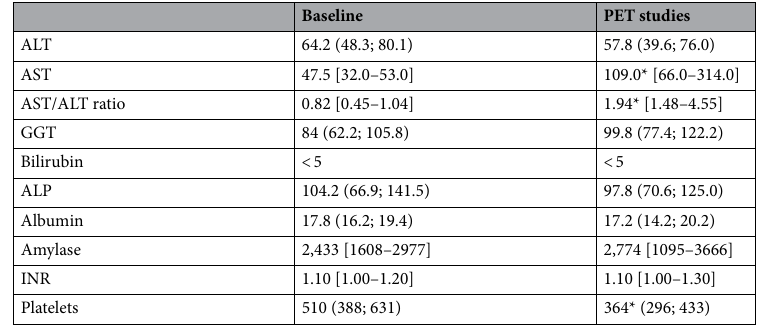
Table 1. Biochemical blood test values from irradiated pigs at baseline and after irradiation: data are shown as mean (95% confidence interval) or median [range]; the groups were compared using the Paired t test or Wilcoxon signed-rank test, when appropriate (n = 5 per group). ALT alanine aminotransferase (units/L plasma), AST aspartate aminotransferase (units/L plasma), GGT gamma-glutamyl transferase (units/L plasma), bilirubin (µmol/L plasma), ALP alkaline phosphatase (units/L plasma), albumin (g/L plasma), INR International Normalized Ratio (plasma), platelets (× 10 9 /L blood). * P < 0.05 when compared with